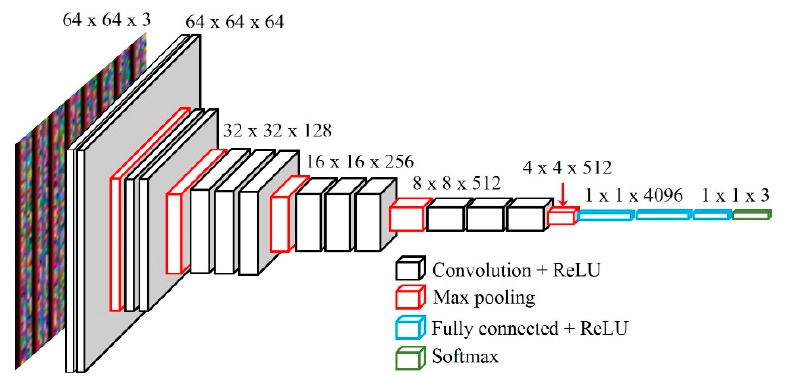
Figure 14. Architecture of the proposed pre-trained VGG-16.